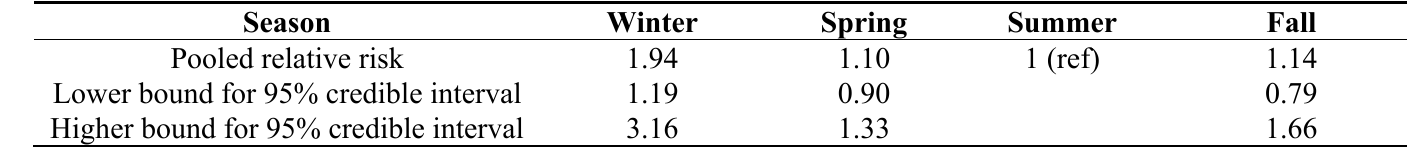
Table A12. Pooled relative risks and 95% credible interval for the association between season of birth on eclampsia incidence. Season